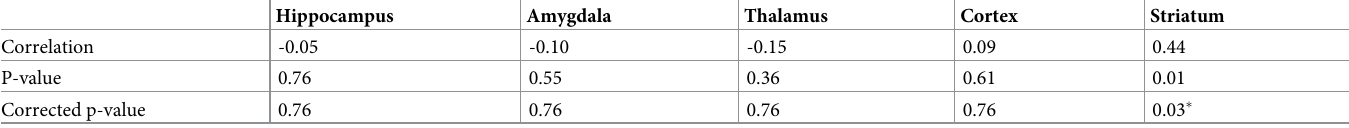
Table 4. Association between PVC 2-[ 18 F]FDG PET SUVR and MRI volume, corrected for ICV.